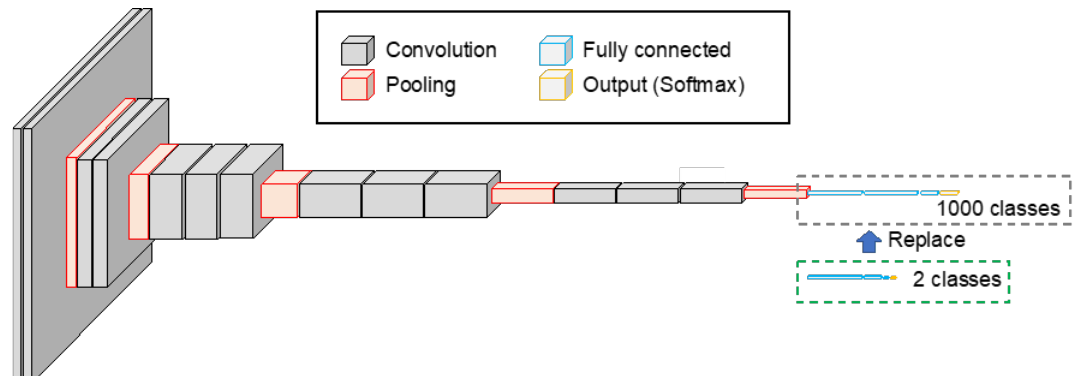
Figure 2. CNN architecture introduced to the proposed scheme. Two-class classification model was built by replacing the fully connected layer of the VGG-16 model.